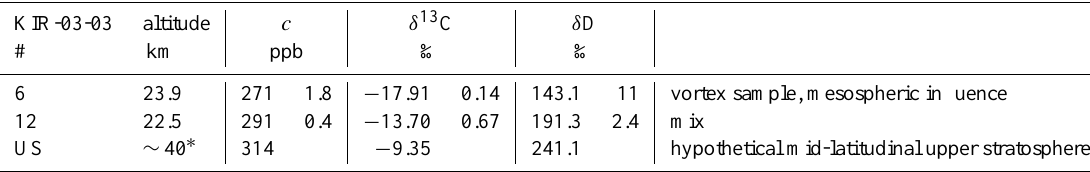
Table 8. Comparison of two samples from flight KIR-03-03, where mesospheric air was sampled. KIR-03-03/6 is found on the vortex branch of the isotope:isotope relation. It is evident that KIR-03-03/12 must have experienced a different fractionation/mixing history. Although its methane mixing ratio is higher than that of KIR-03-03/6, it is much more enriched. Interpreting KIR-03-03/12 as a result of mixing between vortex air and upper stratospheric air from mid latitudes, an appropriate upper stratospheric end-member is reconstructed (KIR-03-03/US).